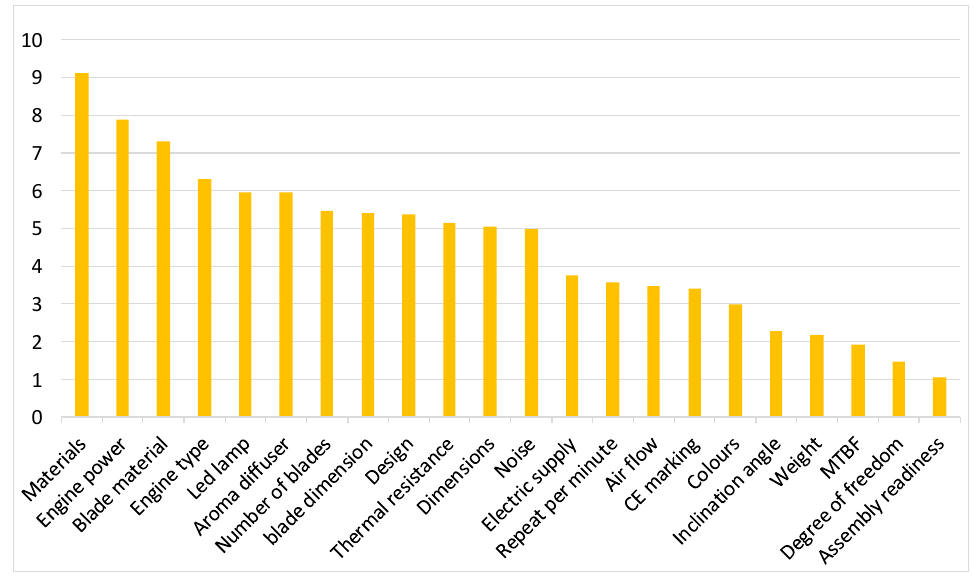
Figure 7. Technical critical Figure. 7. Technical critical variables.